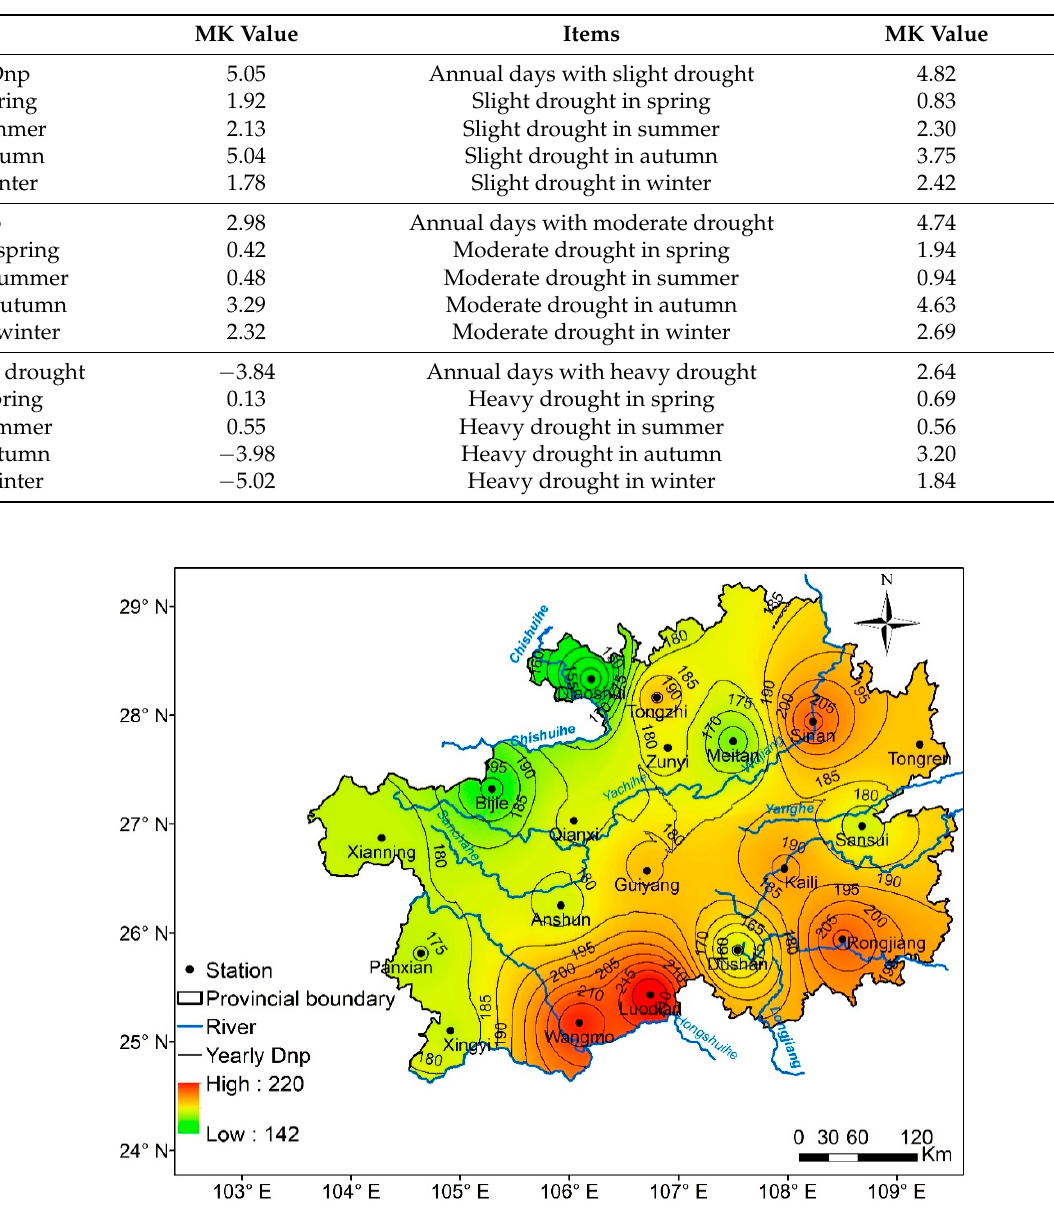
Figure 3. The spatial distribution of yearly Dnp (the drought indicator of continuous days without available precipitation).